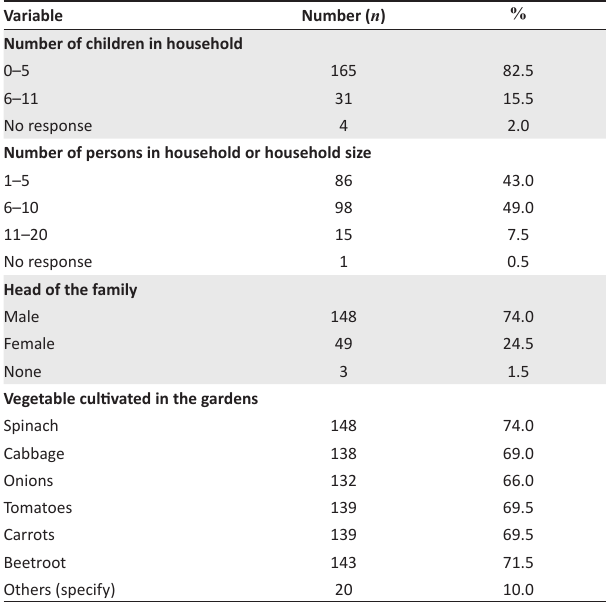
TABLE 2: Educators’ household characteristics ( n =